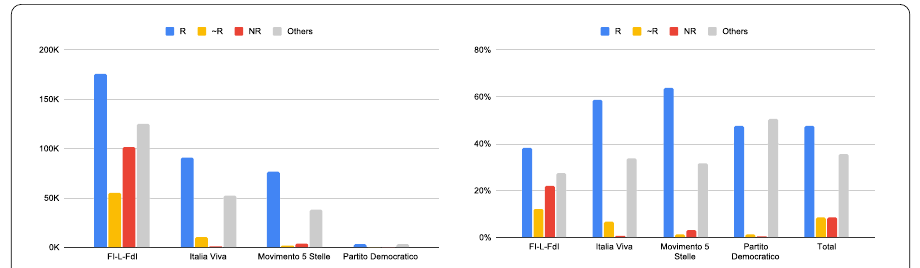
Figure 4 Number (left panel) and percentage (right panel) of Reputable, Circa Reputable, and Non Reputable news sites shared by the political subcommunities – Directed validated